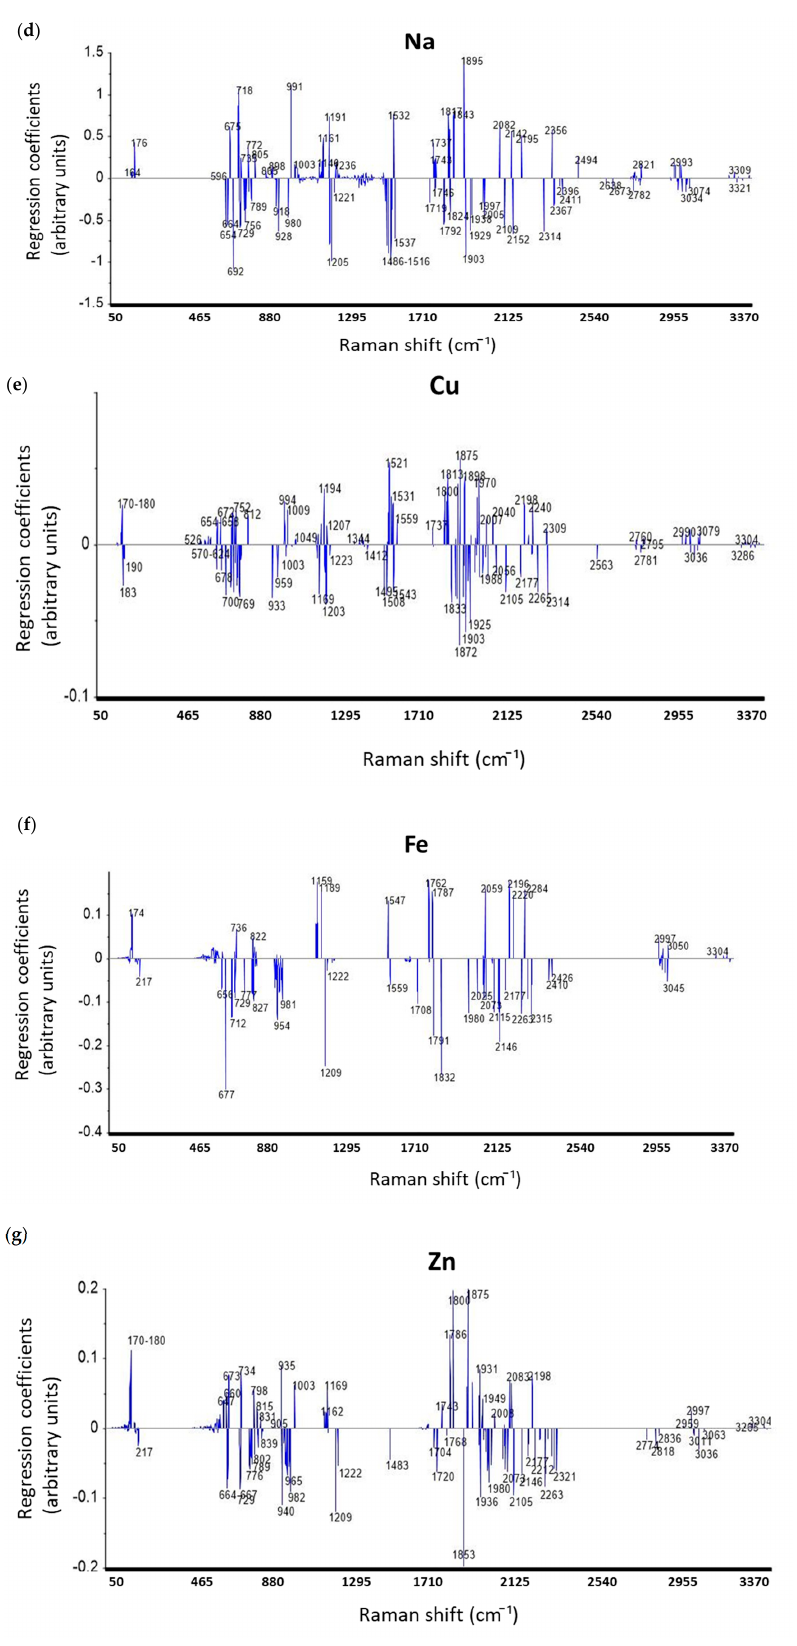
Figure 3. Regression coefficients plots of all aqueous INF samples ( n =83) for the prediction of ( a ) Ca, ( b ) Mg, ( c ) K, ( d ) Na, ( e ) Cu, ( f ) Fe, and ( g ) Zn. Raman spectra of chloride salt solutions (1 M of NaCl, CaCl 2 , CuCl 2 , FeCl 3 , KCl, MgCl 2 , MnCl 2 , and ZnCl 2 ) were also collected to observe Raman spectral variations caused by mineral element content. The AsLs baseline-corrected Raman spectra of these chloride salt solutions are illustrated in Figure 4. Differences in these spectra can be observed in the Raman frequency range of 50–3398 cm − 1 , especially in the range of 50–465 cm − 1 . However, the Raman signal noise level was found to increase gradually in the range of 1800–3398 cm − 1 , and the spectral variance of different chloride salt solutions cannot be clearly observed in 1800–3398 cm − 1 . Thus, the Raman signal in this frequency range cannot be used to compare with the corresponding Raman shifts of high regression coefficient intensity in the same frequency range. Correspondingly, significant regression coefficient intensities of the minerals determined (Figure 3b–g) can also be observed at specific Raman shifts around 170–220 cm − 1 for minerals’ prediction (Figure 4). Therefore, it is aware that 170–220 cm − 1 of Raman shifts are related to the chelated backbones of Mg, K, Na, Cu, Fe, and Zn ions. These control experiments on chloride salts using RS demonstrated that Raman spectra can be directly used to specify the chelated backbones of multi-minerals. On the other hand, these results also agreed to the method using regression coefficient intensities from PLSR modeling for the identification of the chelated backbones in a chemical complex.